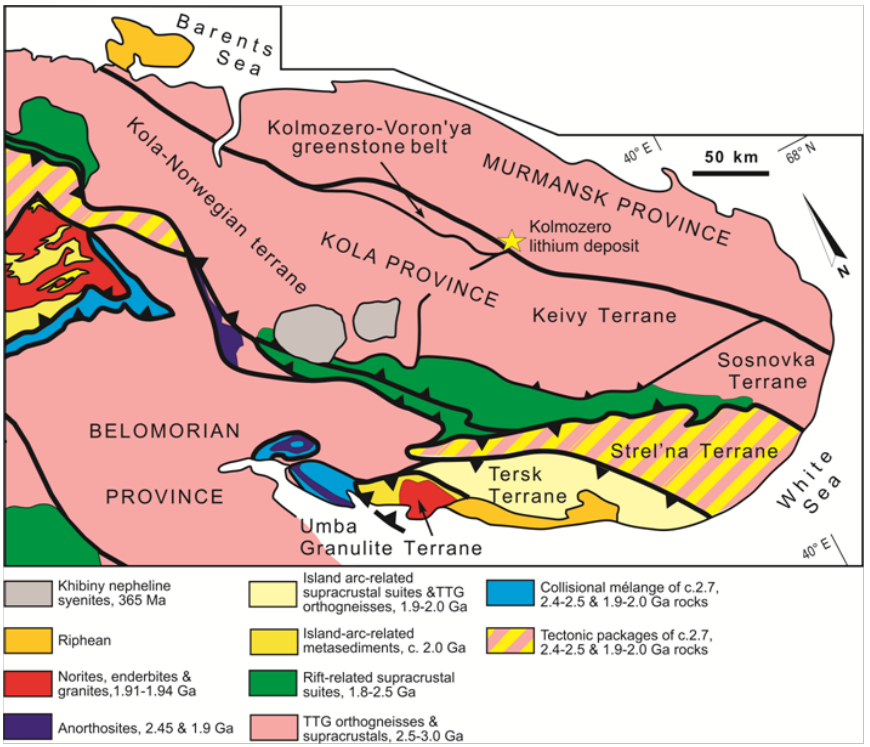
Figure 1. Tectonic provinces of the north-eastern Fennoscandian Shield. Modified after Daly et al. [16]. The asterisk marks the area shown in Figure 2.